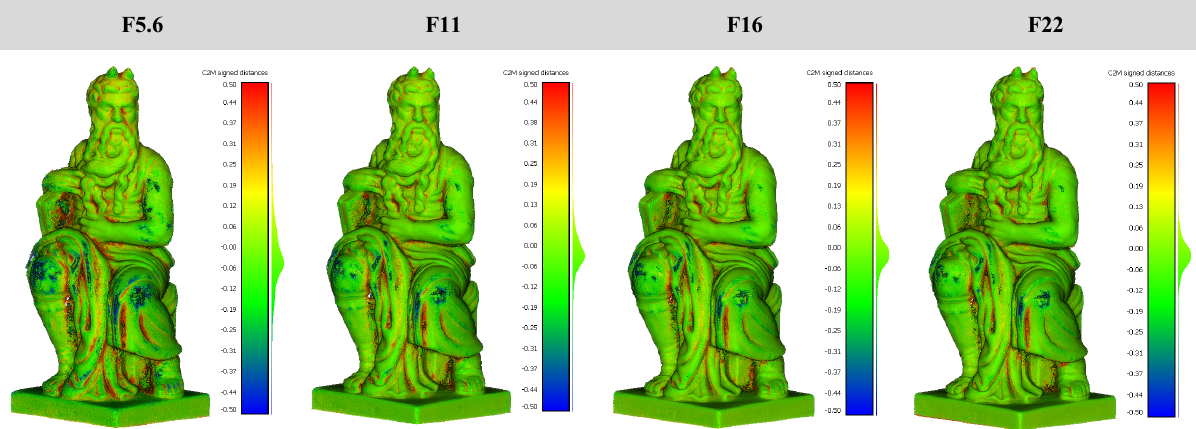
Figure 3. Cloud-to-Mesh comparison [mm] with F5.6, F11, F16 and F22 for the Moses statue. Range [-0.50/0.50 mm]. Results confirm fewer divergences from the ground truth with higher